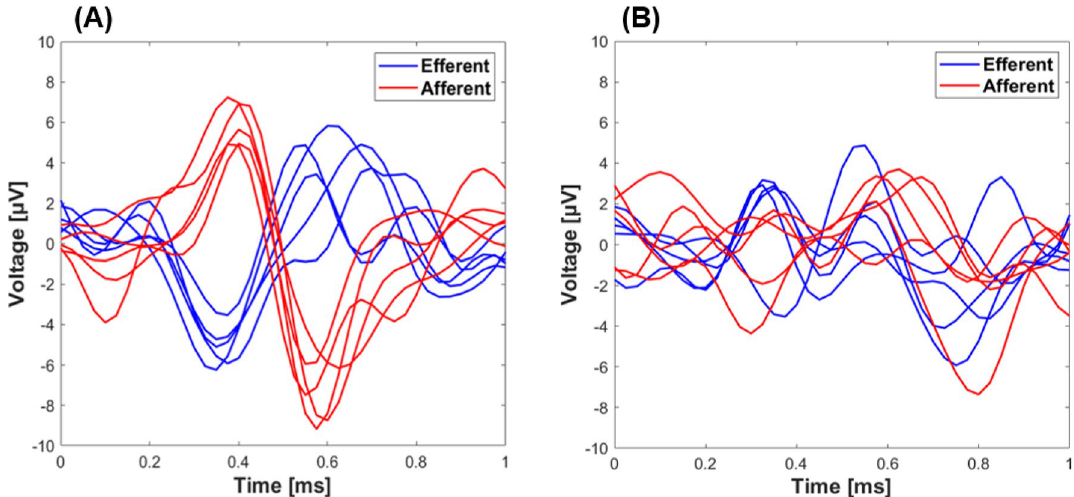
Figure 3. Sample data of neural recordings obtained from a single experiment, where the vagus nerve was transected only proximally (afferent) or distally (efferent) from the nerve cuff electrode. Signals representing ( A ) synchronized and ( B ) asynchronized ENG signals were plotted in 1 ms windows. [x-axis: time = 0–1 ms; y-axis: amplitude = − 10–10